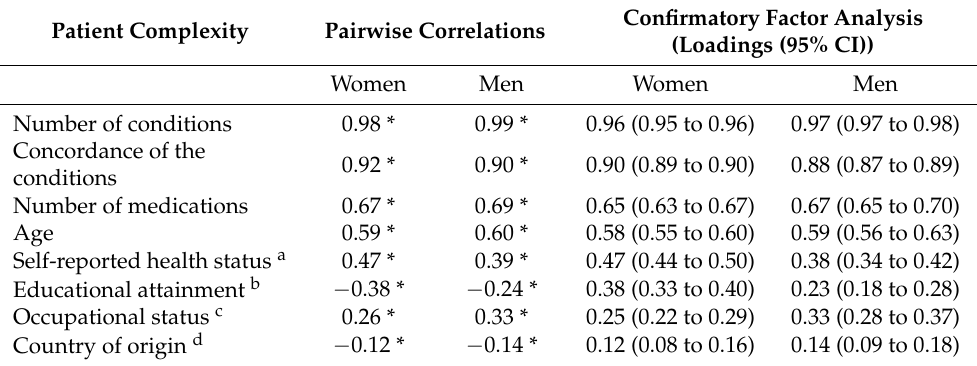
Table A2. Description of the patient complexity latent variables: pairwise correlations between each of the selected indicators for patient complexity and the patient complexity latent variable and loadings in the confirmatory factor